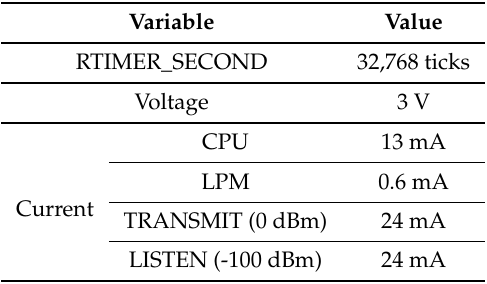
Table 1. Energest-related values for TI CC2538